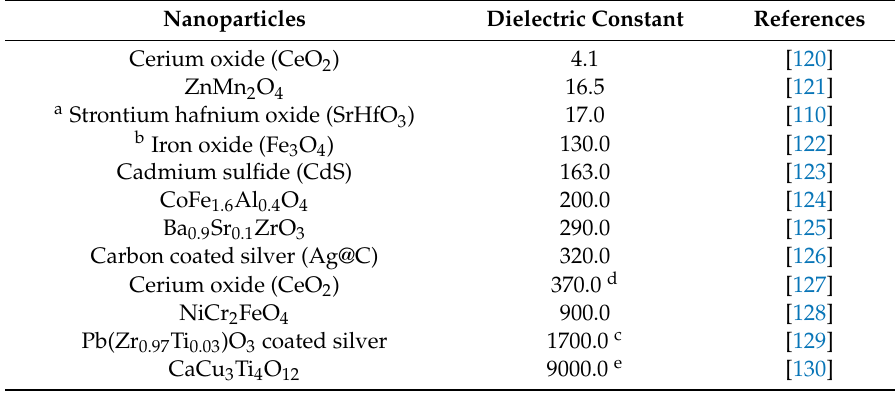
Table 2. Dielectric constant of some of the selected